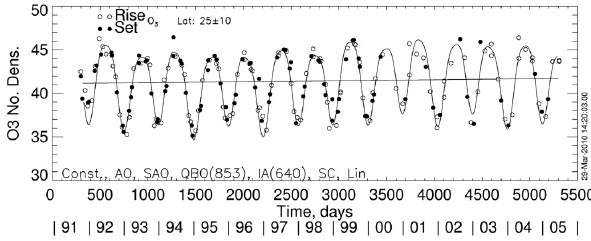
Fig. 3. As in Fig. 2, but for 5 ◦ N and 35km.